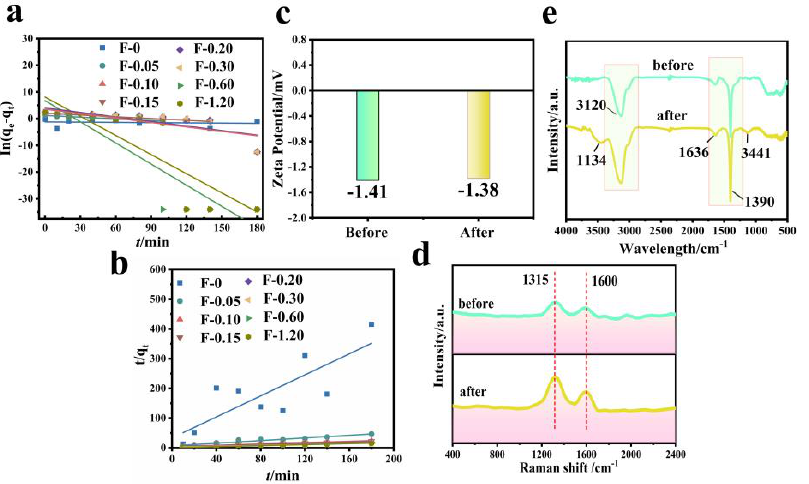
Figure 11. ( a ) First − order kinetic simulation of RhB adsorption by composite membrane. Reaction conditions: RhB (40 mg/L, 60 mL), composite membrane (0.2 g). ( b ) Second − order kinetic simulation of RhB adsorption by composite membrane. Reaction conditions: RhB (40 mg/L, 60 mL), composite membrane (0.2 g). ( c ) Zeta potential before and after RhB adsorption by CGS. Reaction conditions: RhB (40 mg/L, 60 mL), CGS (0.2 g). ( d ) Raman spectrum before and after RhB adsorption by CGS. Reaction conditions: RhB (40 mg/L, 60 mL), CGS (0.2 g). ( e ) FTIR spectrum before and after RhB adsorption by CGS. Reaction conditions: RhB (40 mg/L, 60 mL), CGS (0.2 g).